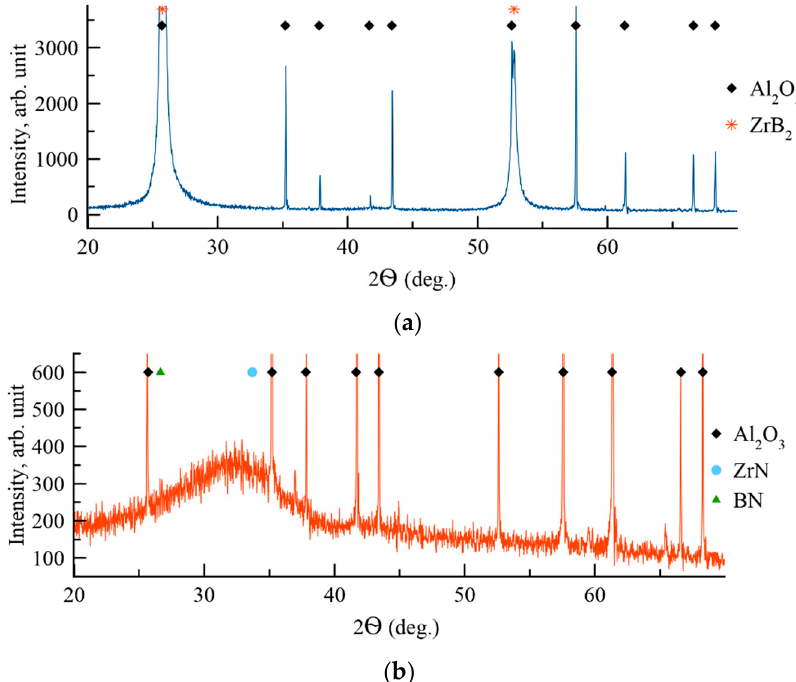
Figure 4. XRD patterns of Coatings 1A ( a ) and 2N ( b ).